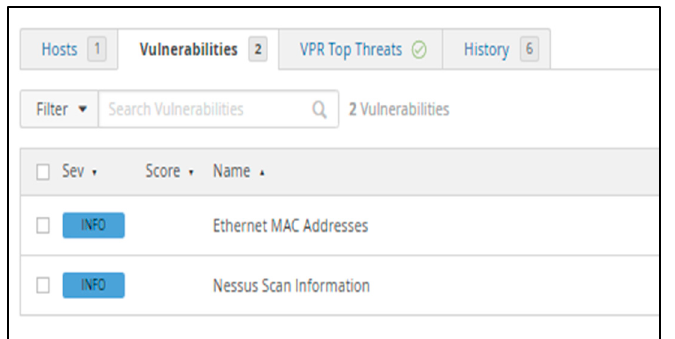
Figure 16. Nessus report after